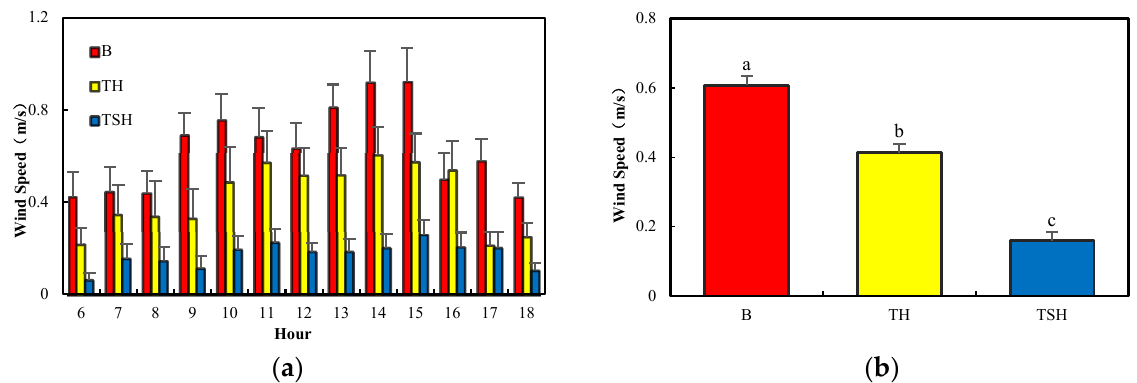
S TH was higher than S TSH . There were some differences in wind speed among different vegetation type combinations. Figure 7b shows that S B > S TH > S TSH , which was similar to the temperature variation. S B , S TH and S TSH were approximately 0.61 ± 0.03, 0.44 ± 0.02 and 0.16 ± 0.01 m/s, respectively. There were significant differences in wind speed among the different vegetation type combinations ( p < 0.05). different vegetation type combinations ( p < 0.05).